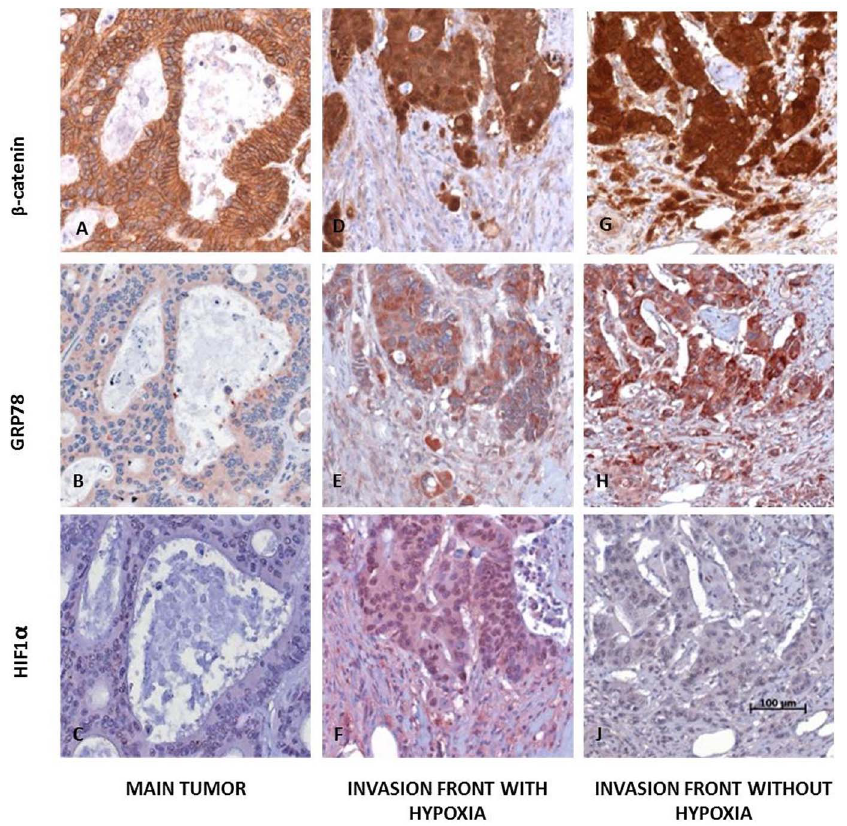
Figure 3. Human colorectal carcinomas with EMT show ER stress independent of HIF1 a . In central tumor areas of human CRCs b -catenin was typically localized at the cell membrane (A) whereas only a weak staining was observed for cytoplasmic GRP78 (B) and HIF1 a staining was found to be negative (C). At the invasion front strong nuclear b -catenin was detectable indicating EMT (D, G). In corresponding regions strong cytoplasmic GRP78 expression was found (E, H). In some of the cases an intense nuclear HIF1 a staining was observed (F, with hypoxia), but not in others (I, without hypoxia) (magnification 200 6 ; scale bar: 100 m m).